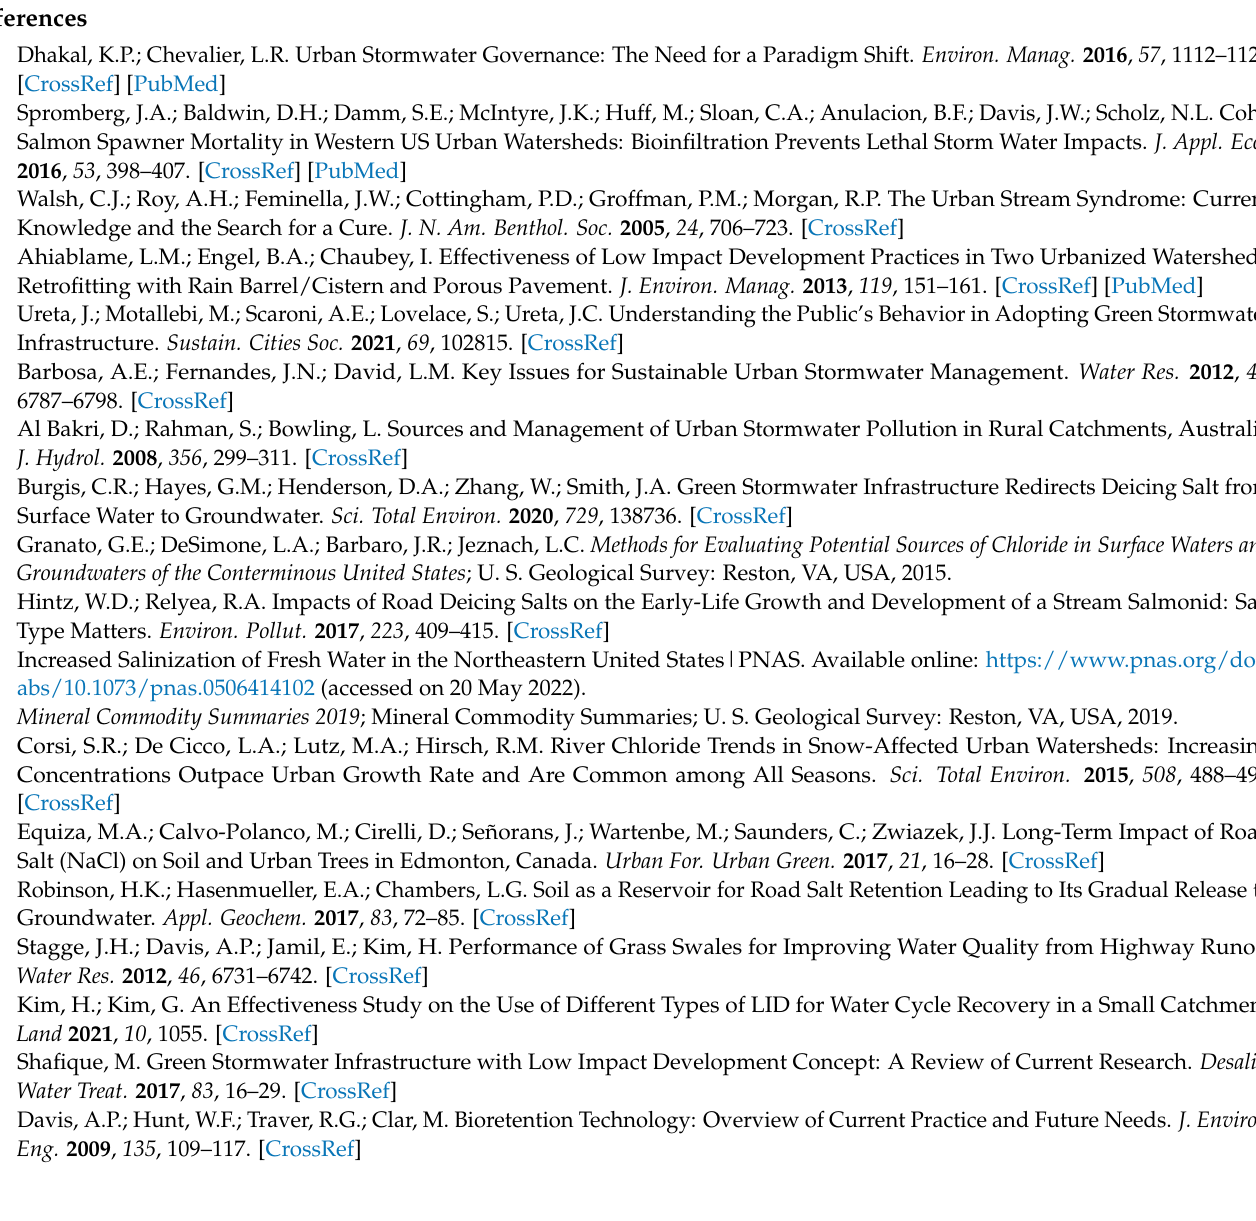
Figure A1. Diagram of the annual precipitation from the Washington Reagan National Airport Weather Station (nearby Lorton Road) between 2011 and